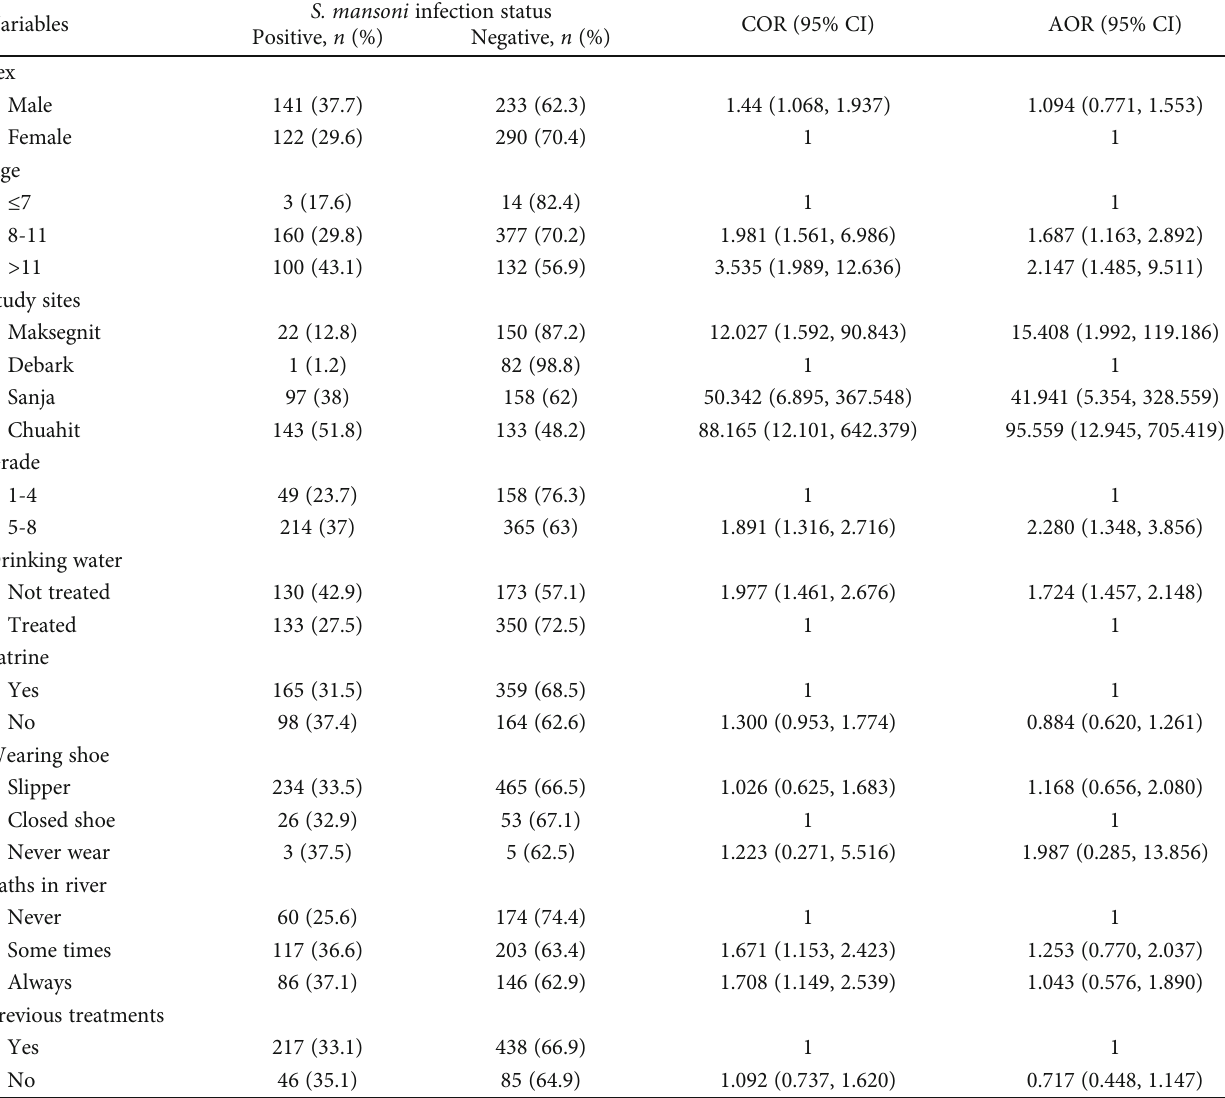
Table 4: Risk factors of S. mansoni infection among the schoolchildren ( n = 786 ) in Northwest Ethiopia,